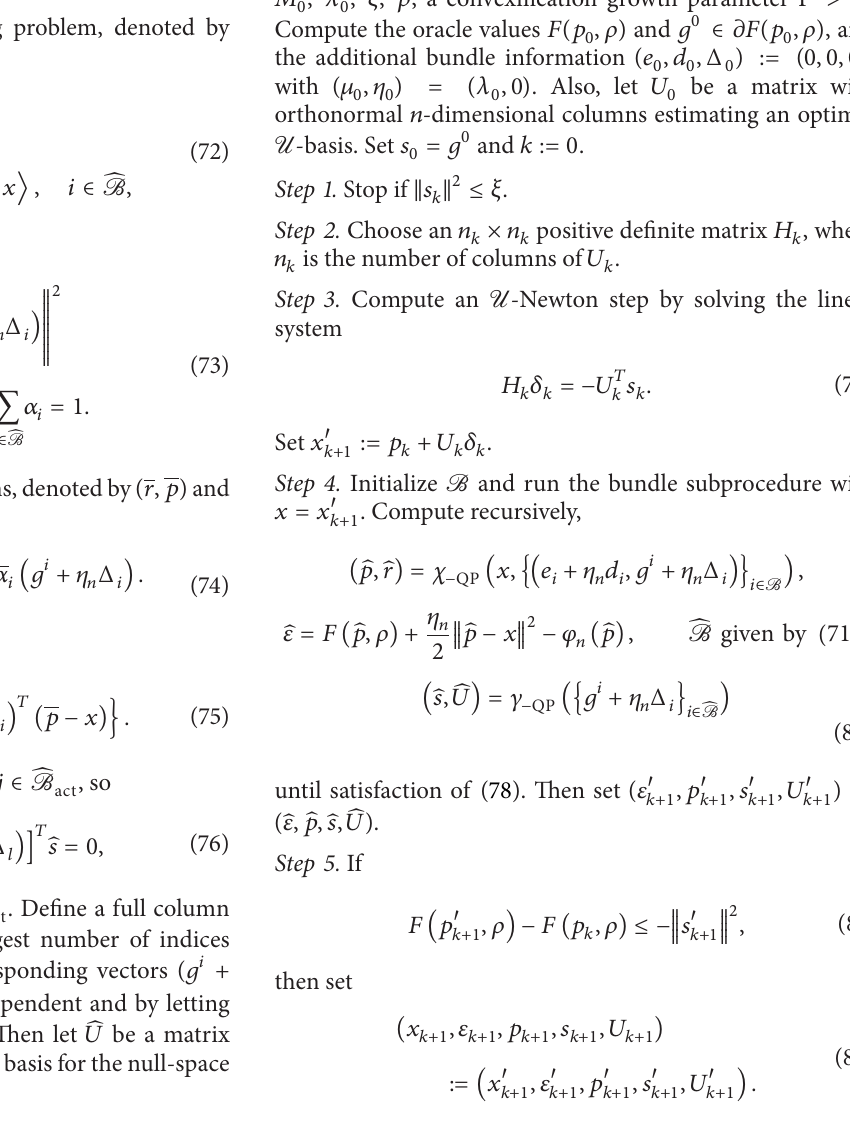
Algorithm 13 (nonconvex VU -Algorithm for